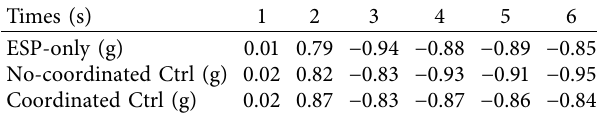
Table 5: Table of Ay with time in Fishhook test condition. Times (s)